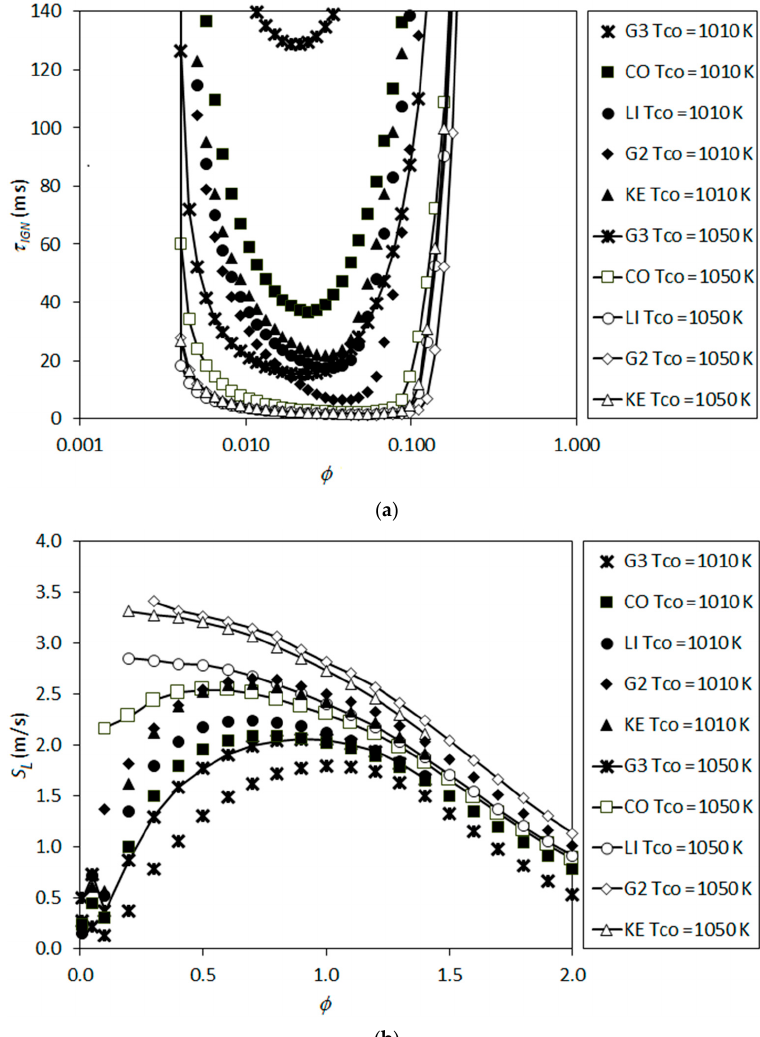
Figure 14. Chemical kinetics parameters predicted by different detailed reaction mechanisms as function of equivalence ratio for the mixtures of the central jet and co-flow stream with varying temperature, ( a ) ignition delay time and ( b ) laminar flame speed (undisturbed planar flame).